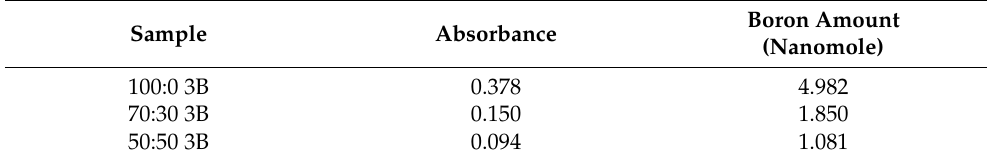
Table 2. Boron amount in one-week culture media (within the degradation product). The presented values are the mean of three replicate